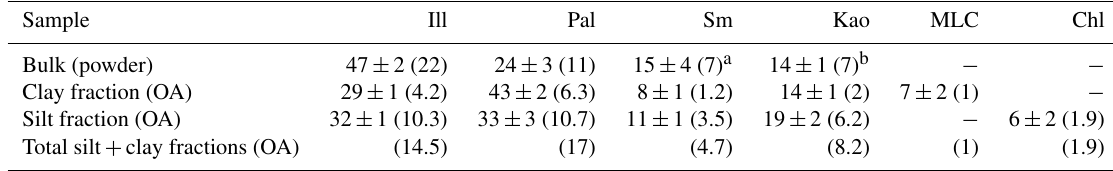
Table 2. Semiquantitative analysis (RIR method) of clay minerals (wt%). Values in parentheses show the wt% content of each type of clay mineral in the bulk sample. Note that the contents of individual clay minerals determined from XRD analysis of the bulk (powder) sample are subjected to a very high uncertainty. More reliable semiquantitative results are obtained from oriented aggregates (OA).